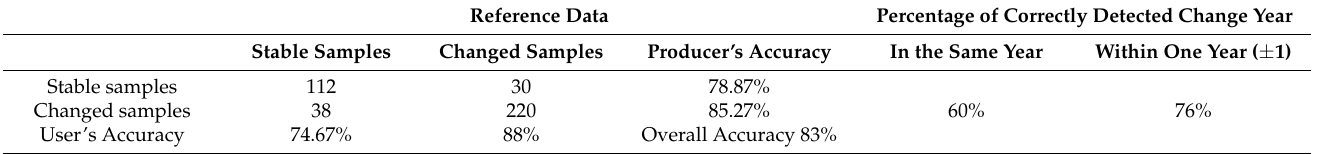
Table 3. Accuracy assessment of change detection